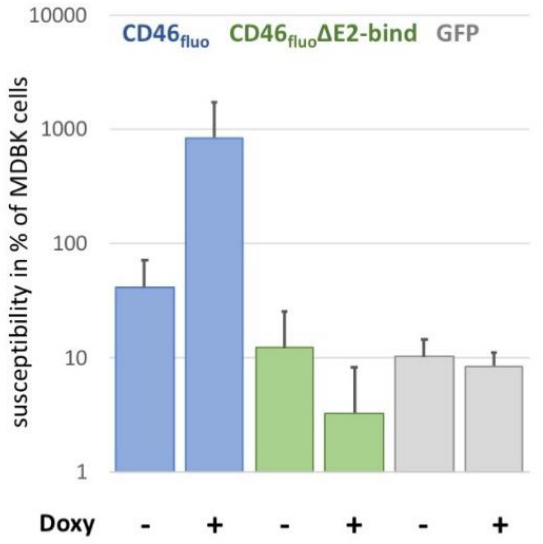
Figure 3. Deletion of CCP-1 reduces CD46 fluo e ff ect of the susceptibility of SK6 cells to the level of GFP-expressing controls. Susceptibility of SK6 CD46 fluo (blue), CD46 fluo ∆ E2bind (green) and GFP-expressing (grey) SK6 cells to infection with BVDV E2-mCherry in % of MDBK cells ( = 100%) with and without the induction of expression by the addition of doxycycline (Doxy) ( n = 6). Cells were infected with serial dilutions of BVDV E2-mCherry for 4 h. Subsequently, medium was exchanged to medium containing 1% carboxymethycellulose and E2-mCherry positive foci were detected 48 h after infection by fluorescence microscopy to determine the focus forming units ( ff u) / mL. Susceptibility of a given cell line was calculated as the percentage of ff u / mL determined for MDBK cells, which was set to 100%.